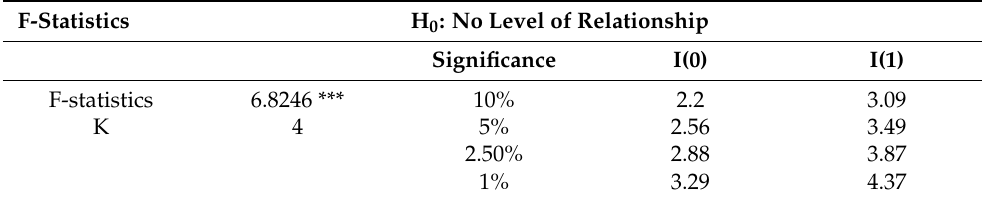
Table 7. ARDL bounds test.